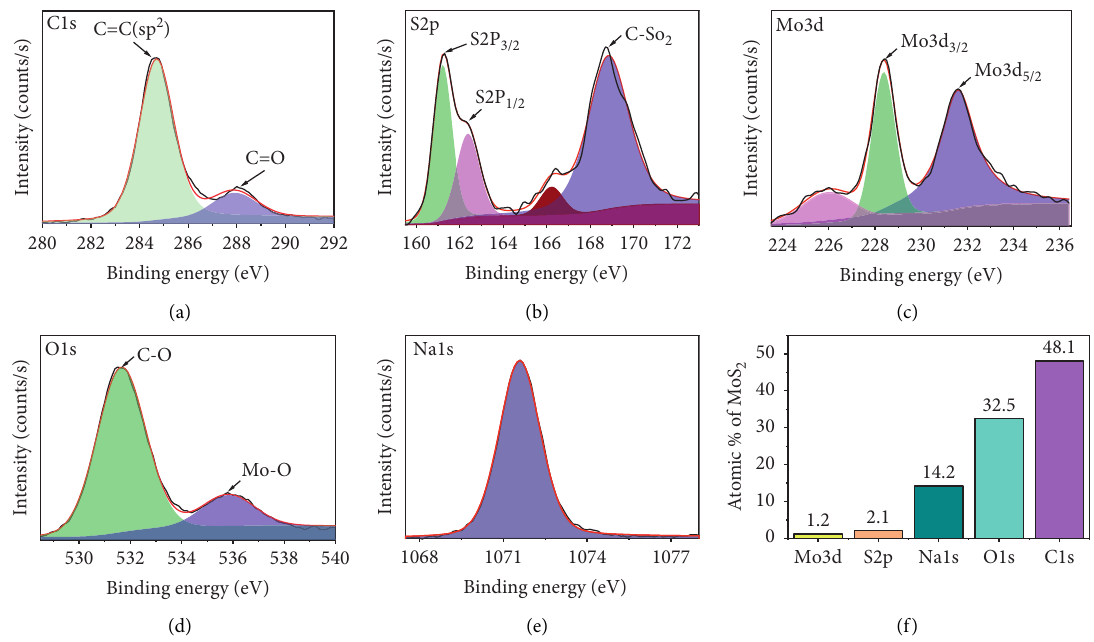
Figure 7: ((a)–(f)) XPS core peak spectrum of (a) C1s, (b) S